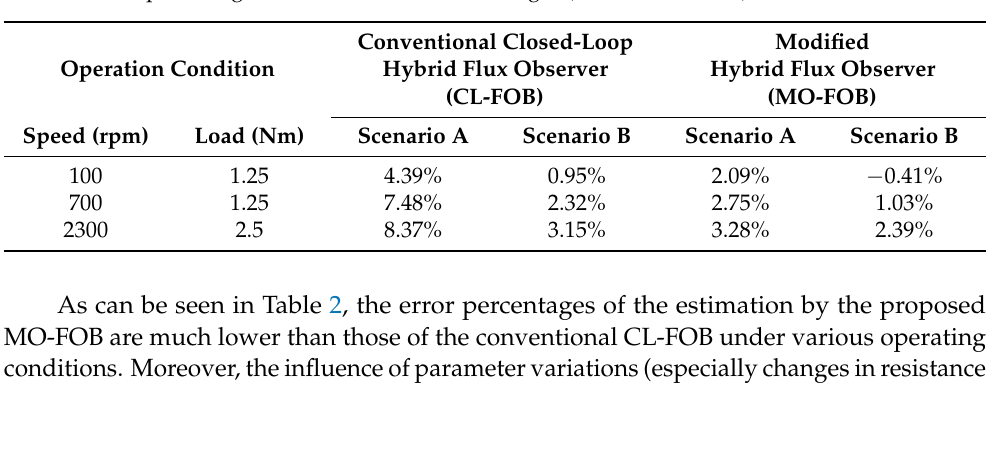
Table 2. Error percentages of the estimated flux linkages (simulation